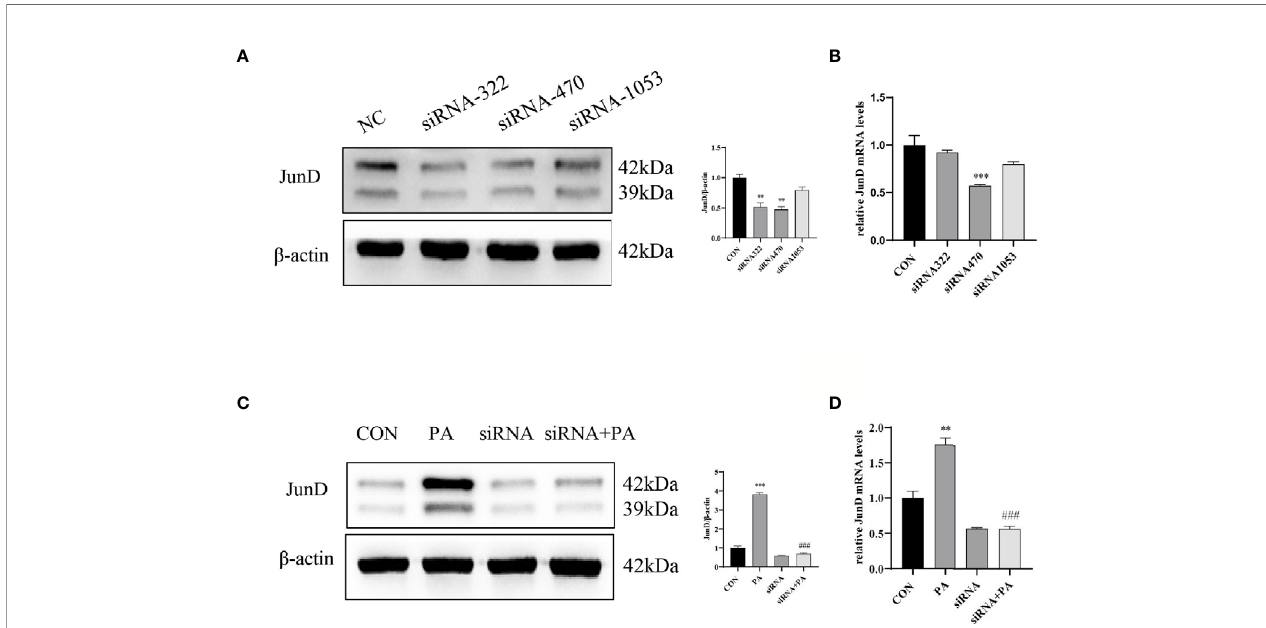
FIGURE 4 | The inhibition ef fi ciency of JunD. (A) Western blot analyses and real-time PCR (B) for inhibition ef fi ciency of JunD in INS-1 cells. (C) The protein and (D) mRNA levels of JunD. Data are expressed as the mean± SEM. **p < 0.01; ***p < 0.001 (compared with control group), ### p < 0.001 (compared with PA